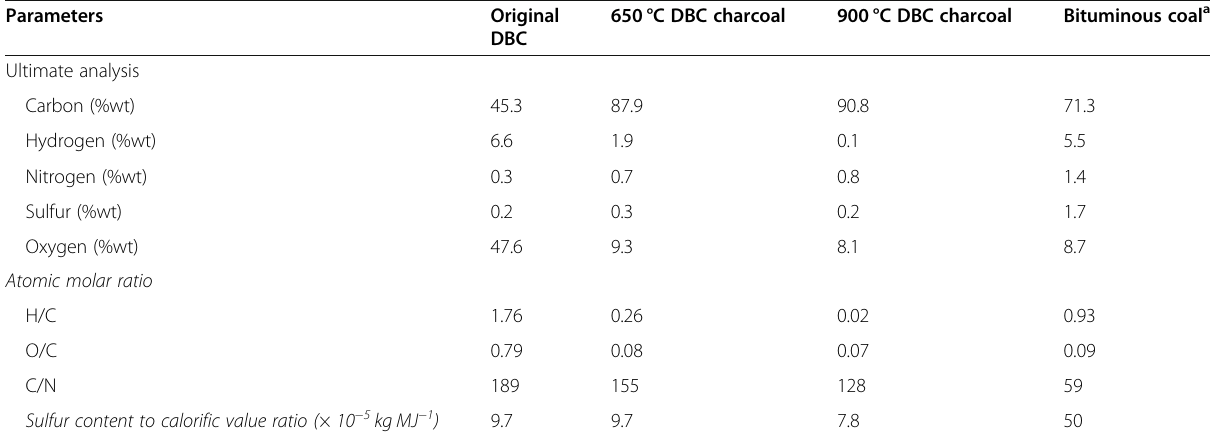
Table 2 Chemical characteristics of the test samples